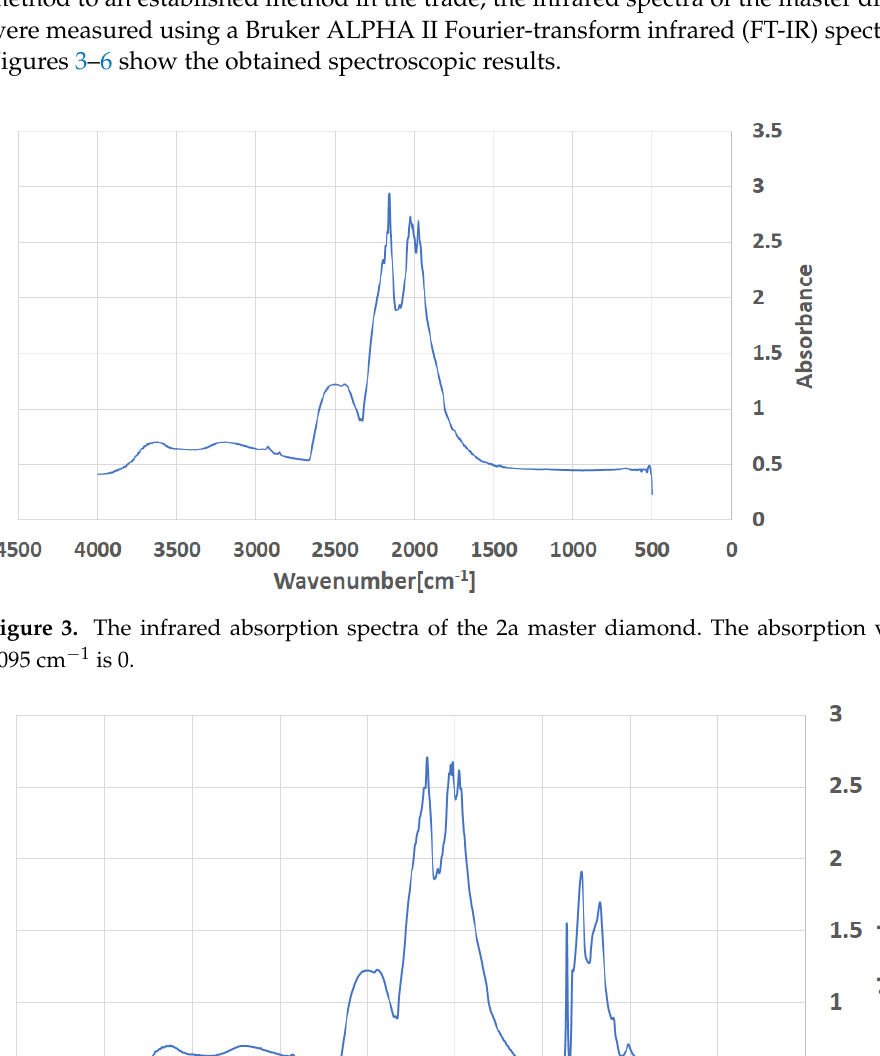
Figure 5. The infrared absorption spectra of the H master diamond. The absorption values at 1095 cm − 1 is 1.14.